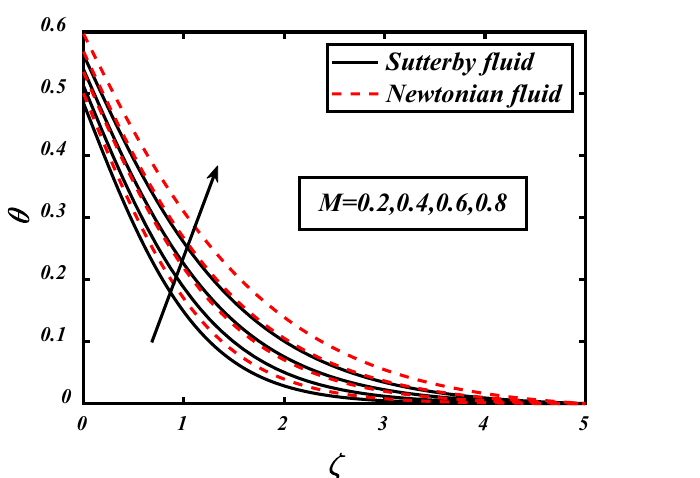
Figure 9. Expounds the impacts of M on θ .